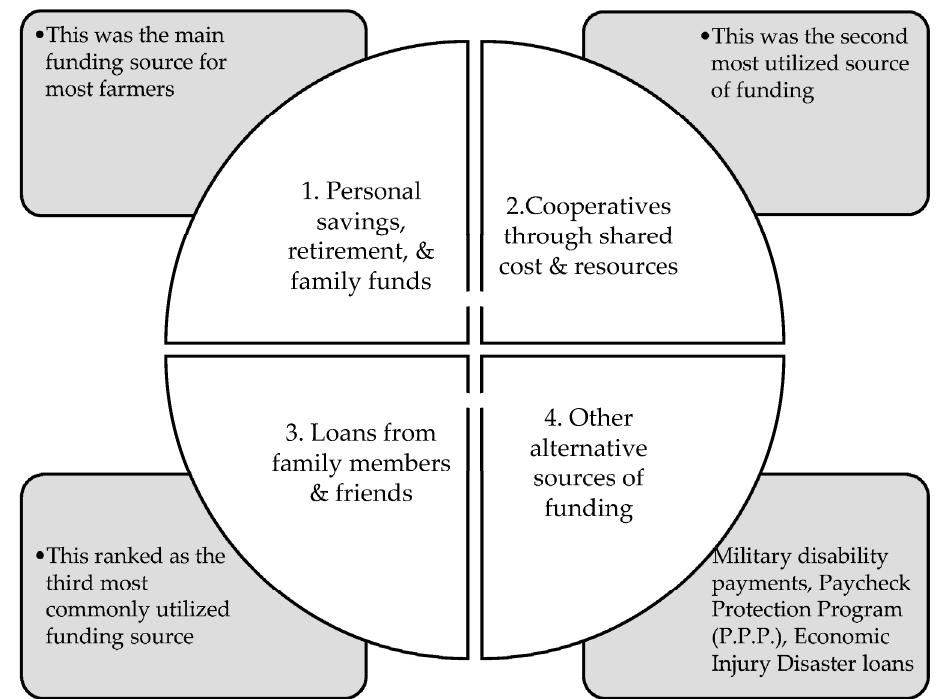
Figure 5. Sources of startup funds.